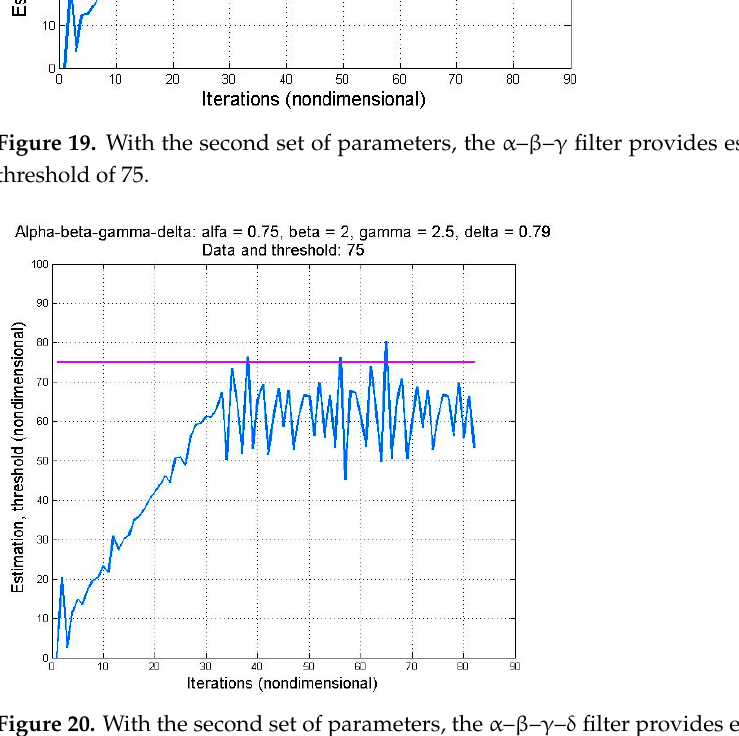
Figure 20. With the second set of parameters, the α – β – γ – δ filter provides estimates that exceed the threshold of 75.